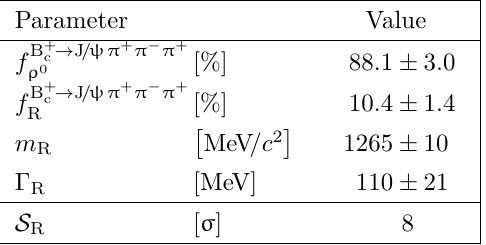
Figure 3 . Background-subtracted (left) (cid:25) + (cid:25) − (cid:25) + and (right) (cid:25) + (cid:25) − mass distributions for se- lected B + → J / (cid:25) + (cid:25) − (cid:25) + candidates. In the left plot the expectation from simulation for c the B + → J / a 1 (1260) + decays with BLL model [26, 28, 43] is overlaid. c Parameter